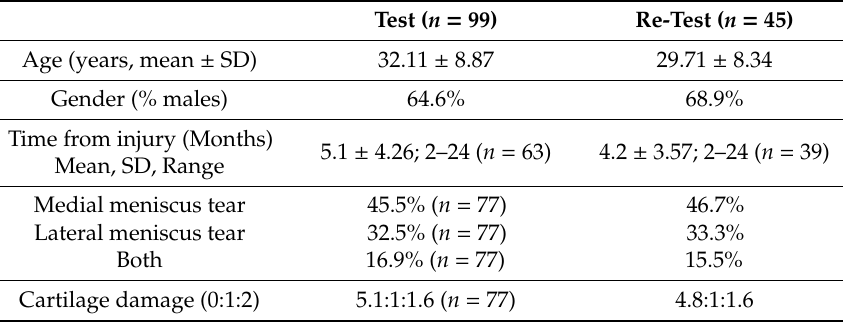
Table 2. Questionnaire results.